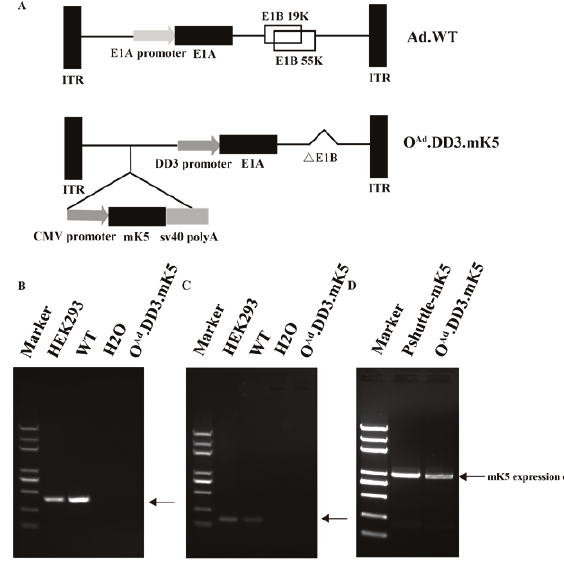
Figure 1: Construction and characterization of O Ad .DD3.mK5. A.